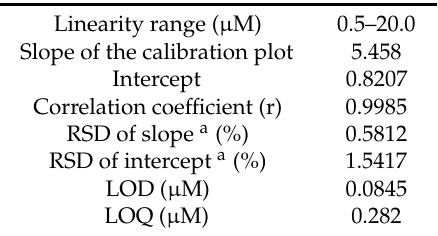
Table 1. Characteristics of AMT calibration plot using di ff erential pulse voltammetry at glassy carbon electrode 0.5 to 20.0 µ